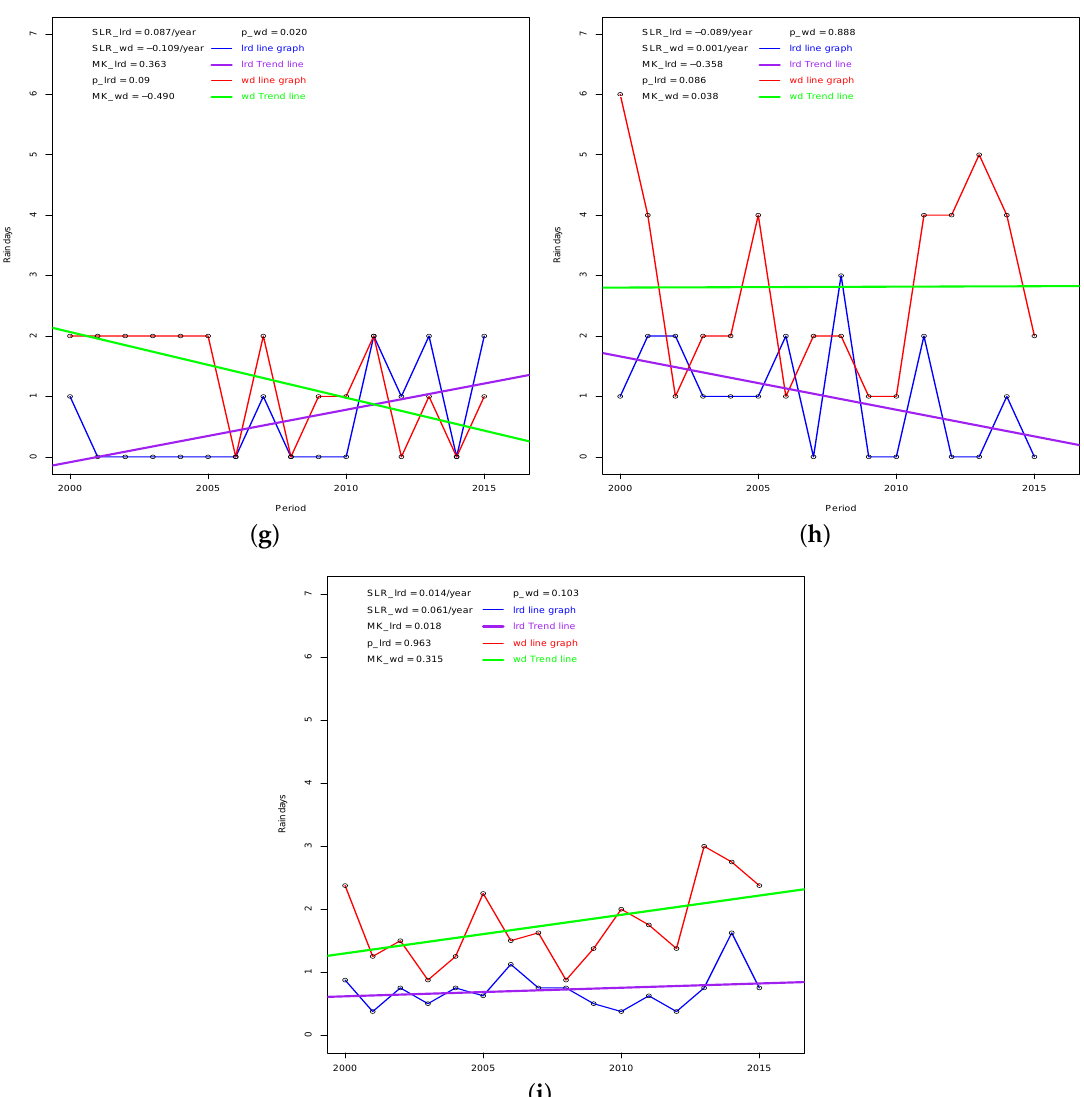
Figure 5. The figure represents the analysis of the light rain days and wet days over the seventh dekad. The vertical axis is the number of rain days, and the horizontal axis is the period. ( a ) Entebbe; ( b ) Jinja; ( c ) Kamenyamigo; ( d ) Kituza; ( e ) Makerere; ( f ) Namulonge; ( g ) Ntusi; ( h ) Tororo; ( i ) Average over the entire region representing the